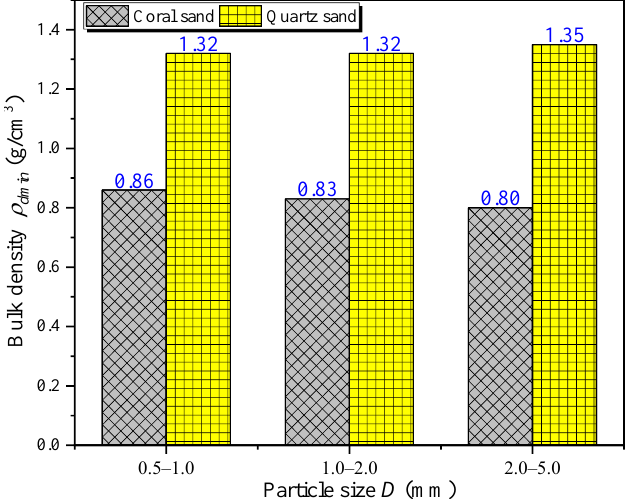
Figure 16. Comparison of bulk density between coral sand and quartz sand with di ff erent particle sizes.